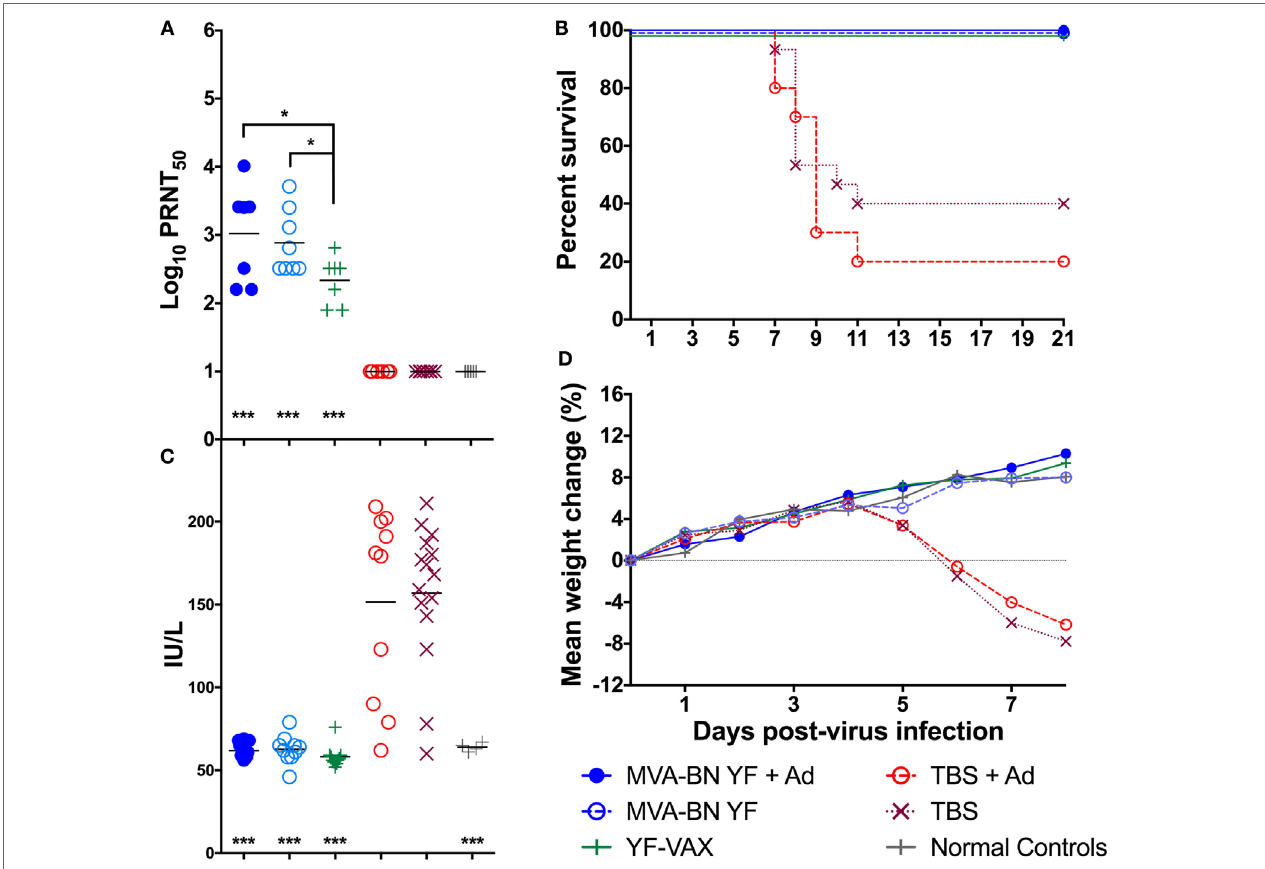
FigUre 1 | (a) Log 10 plaque reduction neutralization titers to YF virus (YFV) were significantly elevated in hamsters vaccinated with MVA-BN YF ± adjuvant or with YF-VAX ® compared with animals vaccinated with vehicle [Tris-buffered saline (TBS)] ± adjuvant or untreated normal controls ( n = 10/group). (B) Vaccination was protective in animals challenged with YFV and (c) serum levels of alanine aminotransferase on day 6 and (D) time-course weight change was improved in hamsters immunized with MVA-BN YF or YFVAX ® (*** p < 0.001, when compared with